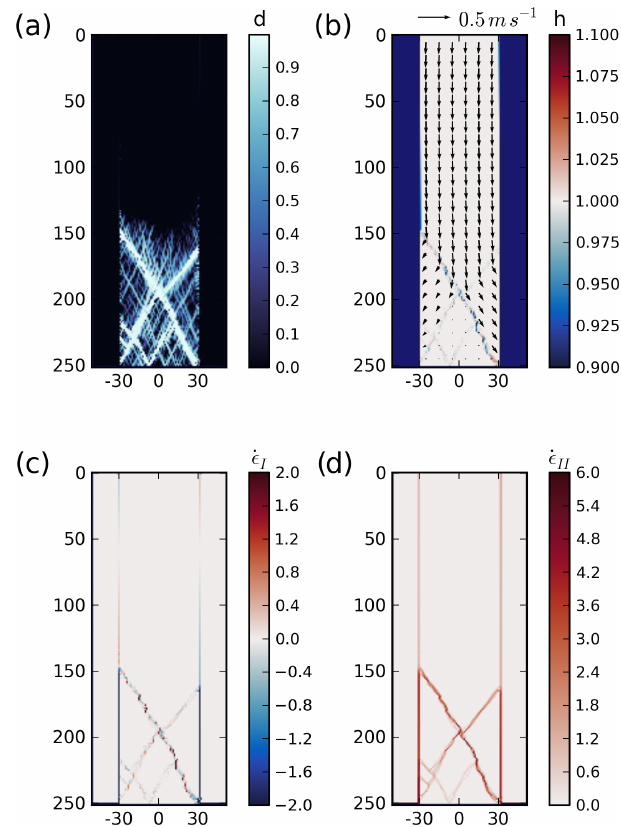
Figure 13. (a) Damage (unitless), (b) ice thickness (m, colour) and velocity vectors (ms − 1 ), (c) mean normal strain rate invariant ( ˙ (cid:15) I , d − 1 ), and (d) maximum shear strain rate invariant ( ˙ (cid:15) II , d − 1 ) after 2h of integration in using the generalized stress correction scheme with γ = 45 ◦ and including heterogeneity in the initial material co- hesion field. The heterogeneous cohesion ( c 0 ) field is defined lo- cally at each grid cell by picking a random number between 7.0 and 13.0kNm − 2 . The remaining initial conditions are the same as all other